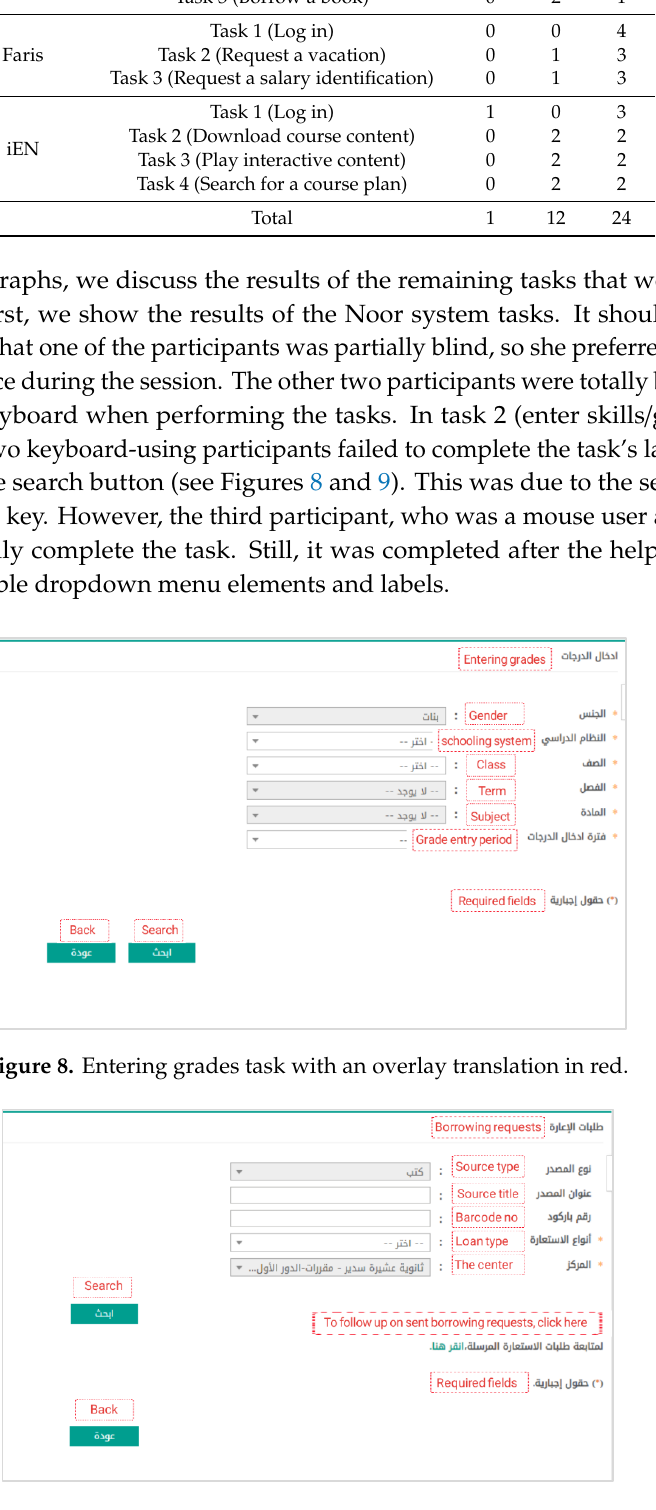
Table 10. Frequency of the completion status for each task: completed (C), not completed (NC), or completed with help (CH).